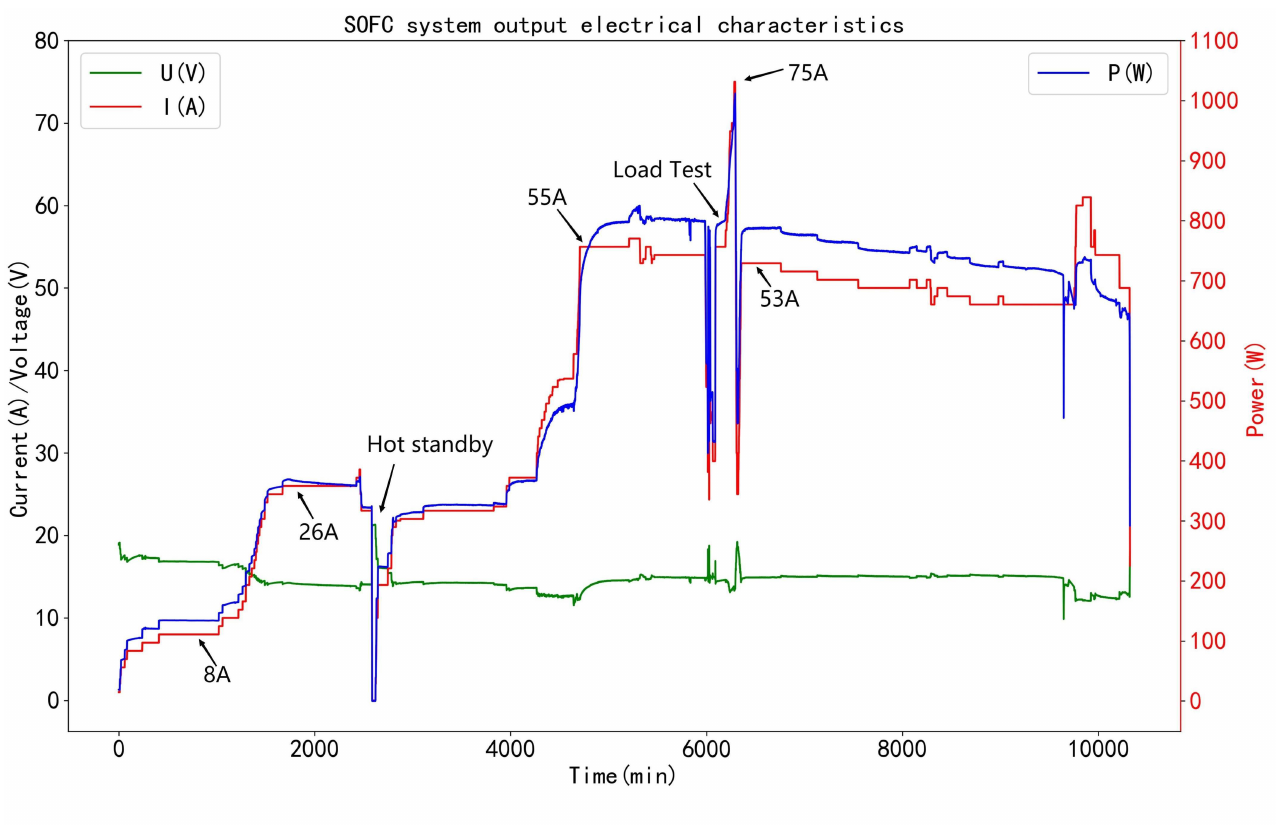
Figure 3. The SOFC system output electrical